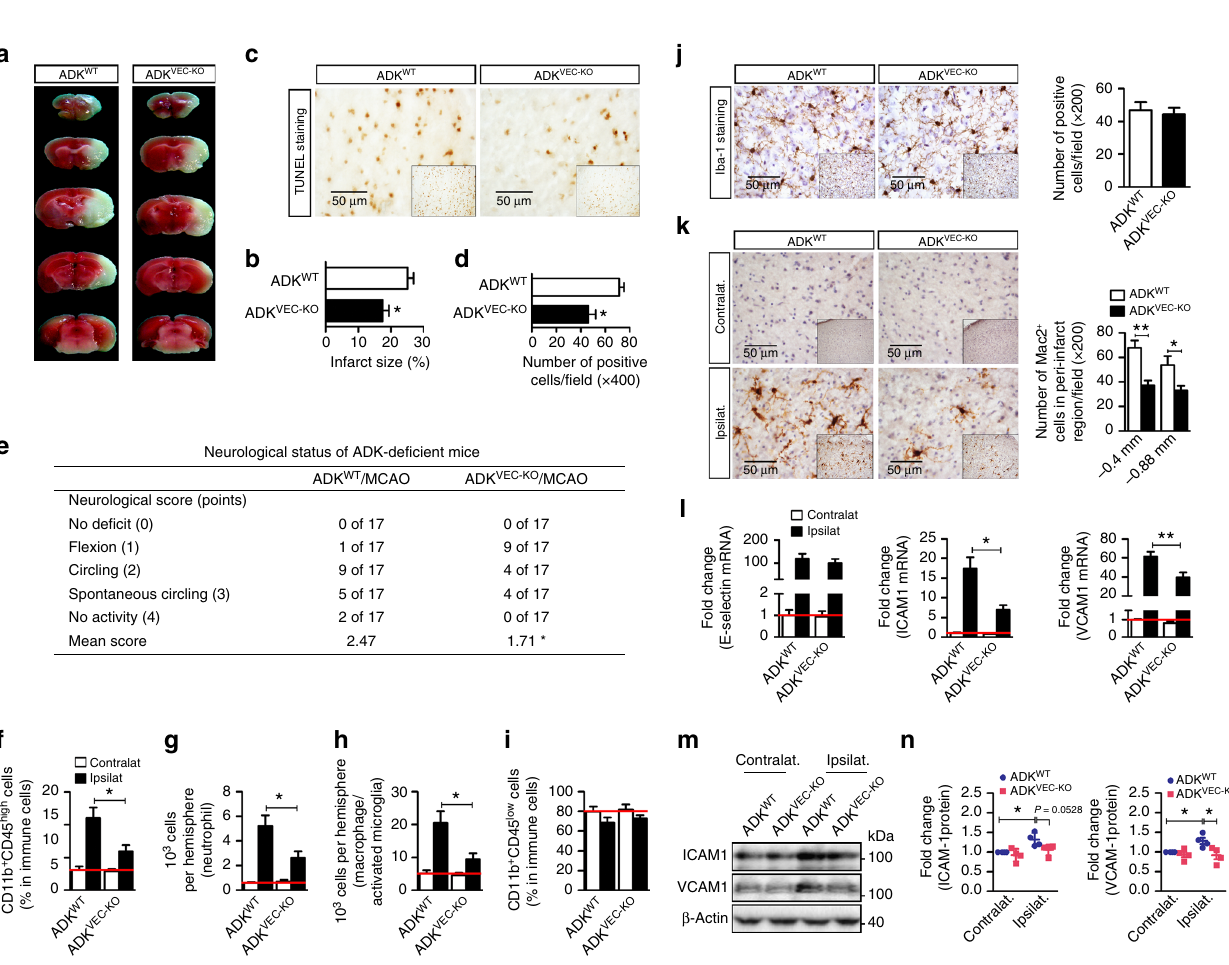
Fig. 7 Endothelial ADK de fi ciency prevents cerebral ischemic injury. a , b 2,3,5-tripenyltetrazolium chloride ( TTC ) staining ( a ) and quanti fi cation of infarct size ( b ) in ADK WT and ADK VEC-KO mice ( n = 10 mice per group). c , d Representative images of TUNEL staining ( c ; scale bar , 50 µ m) and quanti fi cation of TUNEL-positive cells ( d ) in the penumbra of the ipsilateral ischemic cortex (on sections at a level 0.6 mm caudal to the bregma) of ADK WT and ADK VEC-KO mice ( n = 5 per group). e Neurological status of ischemic ADK WT and ADK VEC-KO mice ( n = 10 mice per group). f – i Flow cytometric analysis of in fl ammatory cell populations in the contralateral and ipsilateral brains of ADK WT and ADK VEC-KO mice 24 h post I/R ( n = 6 mice per group). f The ratio of in fi ltrated leukocytes (CD11b + CD45 high ). g The number of in fi ltrated neutrophils (CD11b + CD45 high Ly6G + ). h The number of macrophages/activated microglia cells (CD11b + CD45 high F4/80 + ). i The ratio of resident microglia cells (CD11b + CD45 low ). j IHC staining with Iba-1 antibody and quanti fi cation of Iba-1-positive resting microglia in contralateral brains of ADK WT and ADK VEC-KO mice 24 h post I/R. Representative images were taken in the contralateral cortex on sections at a level 0.5 mm caudal to Bregma ( scale bar , 50 µ m; n = 5 mice per group). k IHC staining and quanti fi cation of Mac2-positive macrophages/activated microglia cells on brain sections of ADK WT and ADK VEC-KO mice 24 h post I/R. Representative images were taken in the penumbra of the ipsilateral ischemic cortex and the corresponding contralateral cortex on sections at a level 0.4 mm caudal to the bregma ( scale bar , 50 µ m; n = 5 mice per group). l mRNA levels for adhesion molecules in brains of ADK WT and ADK VEC-KO mice 24 h post I/R ( n = 6 mice per group). m , n Western blot detection ( m ) and densitometric quanti fi cation ( n ) of adhesion molecule expression in brains of ADK WT and ADK VEC-KO mice 24 h post I/R ( n = 4 per group). For all bar graphs , data are the mean ± SEM, * P < 0.05 and ** P < 0.01 (Unpaired, two-tailed Student ’ s t -test for b , d , and g – m ; one-way ANOVA with Tukey ’ s post hoc test for o